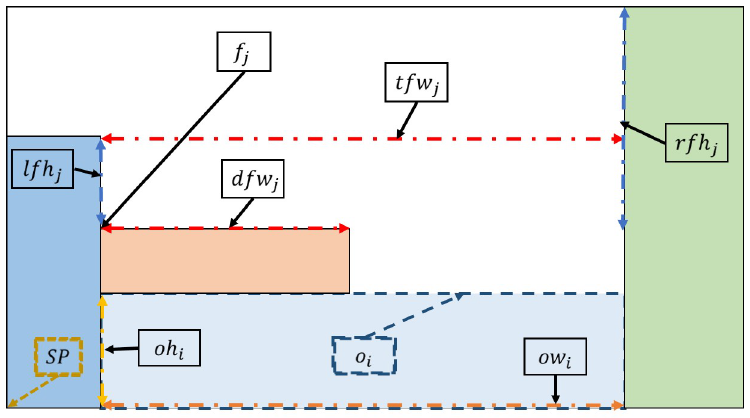
Figure 1. Characteristics of the flags and